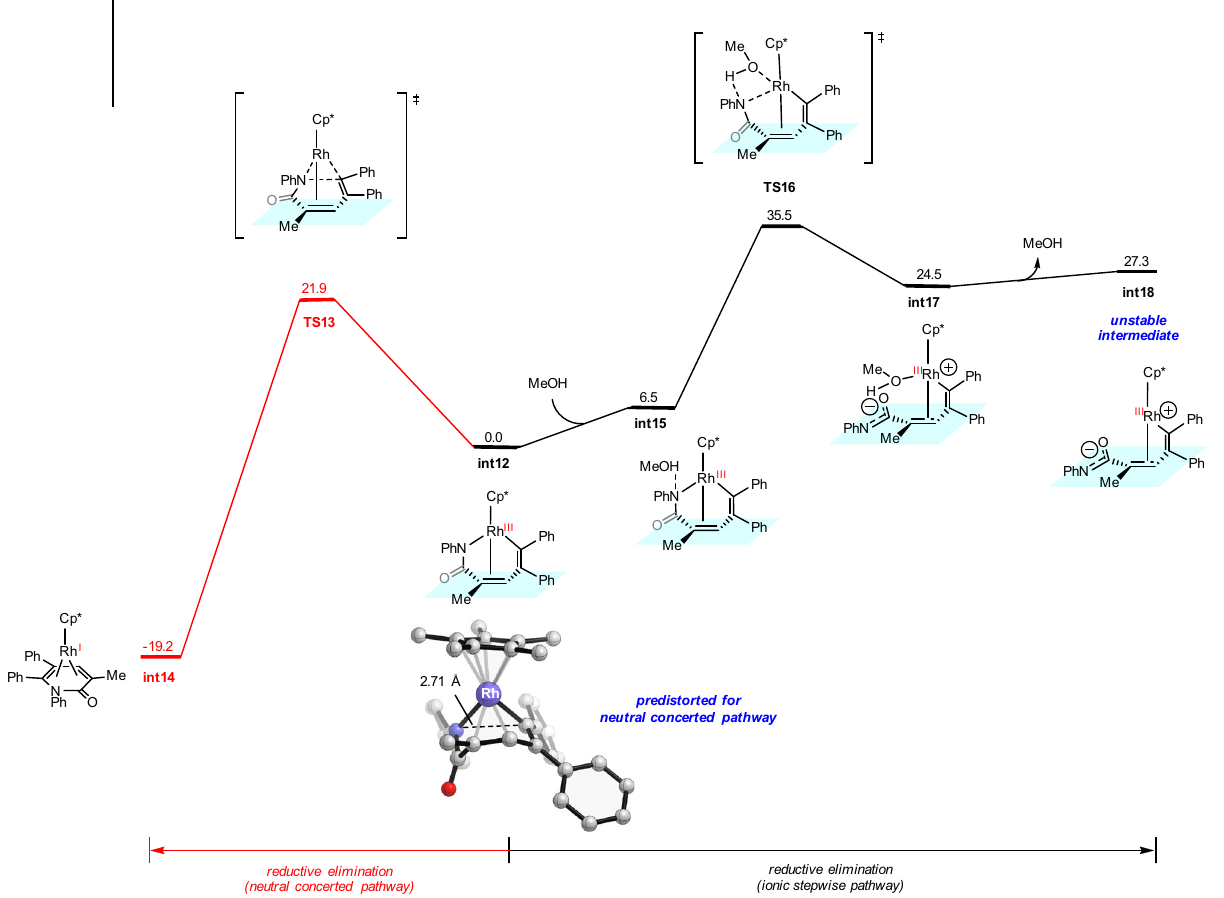
pathway)reductive elimination (neutral concerted pathway) Fig. 8 DFT calculations with 1b substrate. DFT-computed free energy changes of competing reductive elimination pathways from seven-membered ring vinyl-rhodium intermediate int10 when N -phenyl acrylamide 1b was employed as